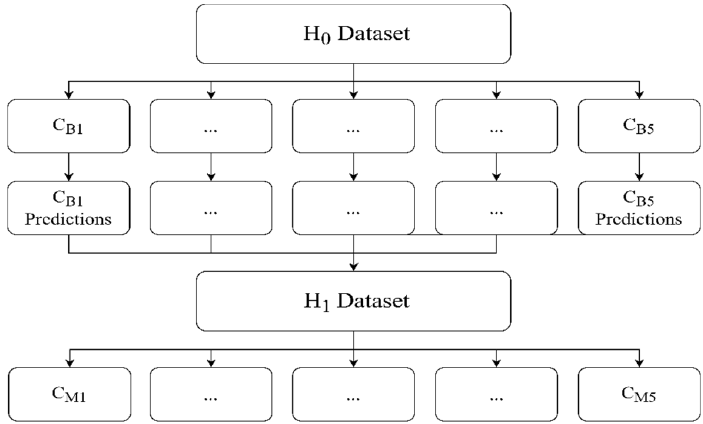
Figure 2. A schematic diagram of the stacking method.